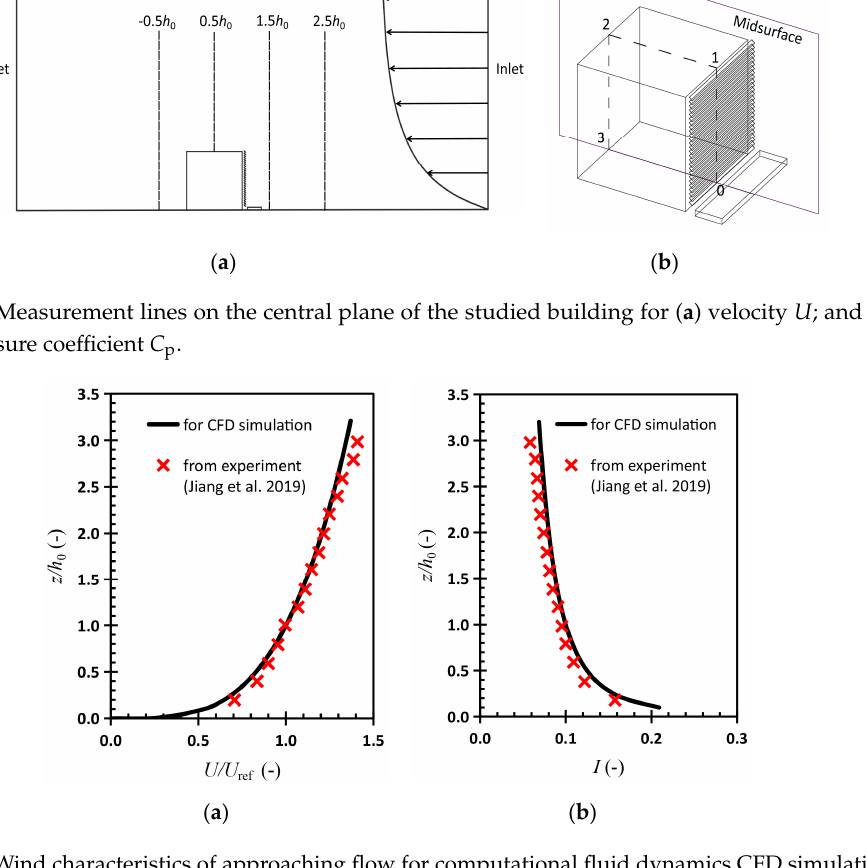
Figure 2. Geometry model of the cube building with shading louvers.